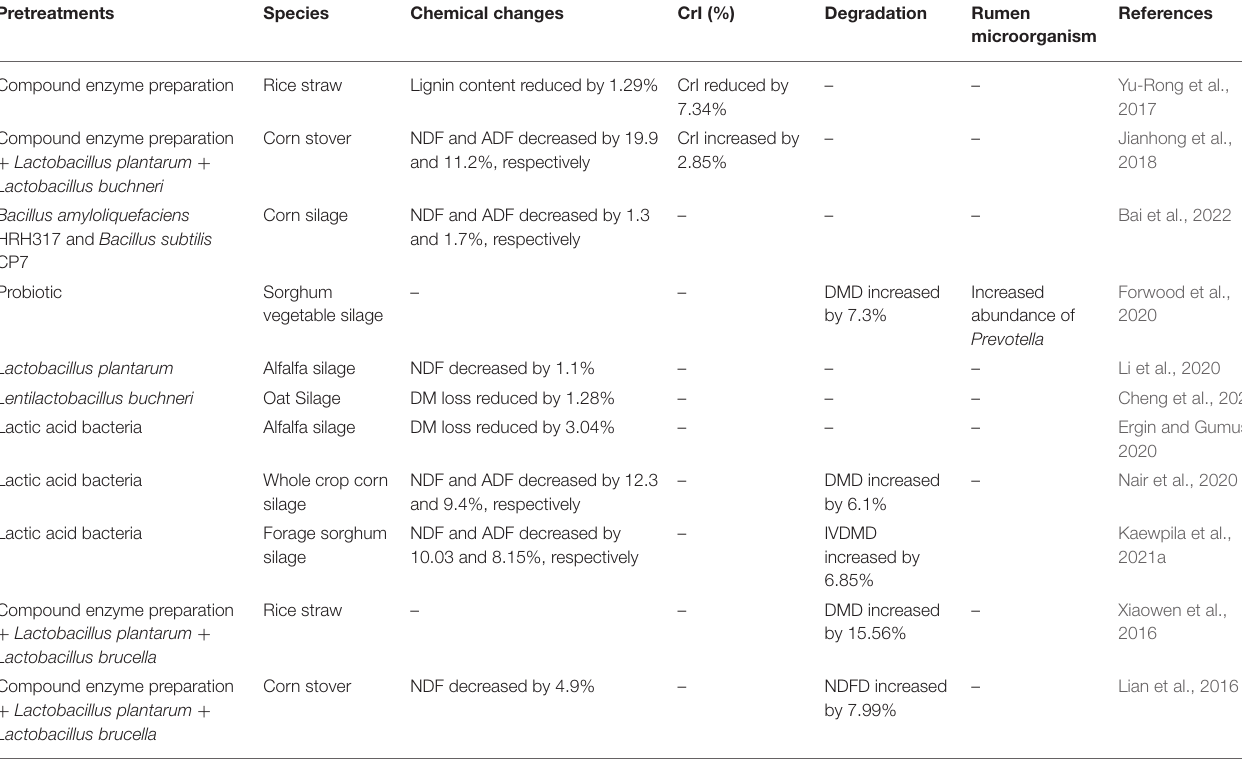
TABLE 4 | Comparison among different studies using various pretreatment methods for rice